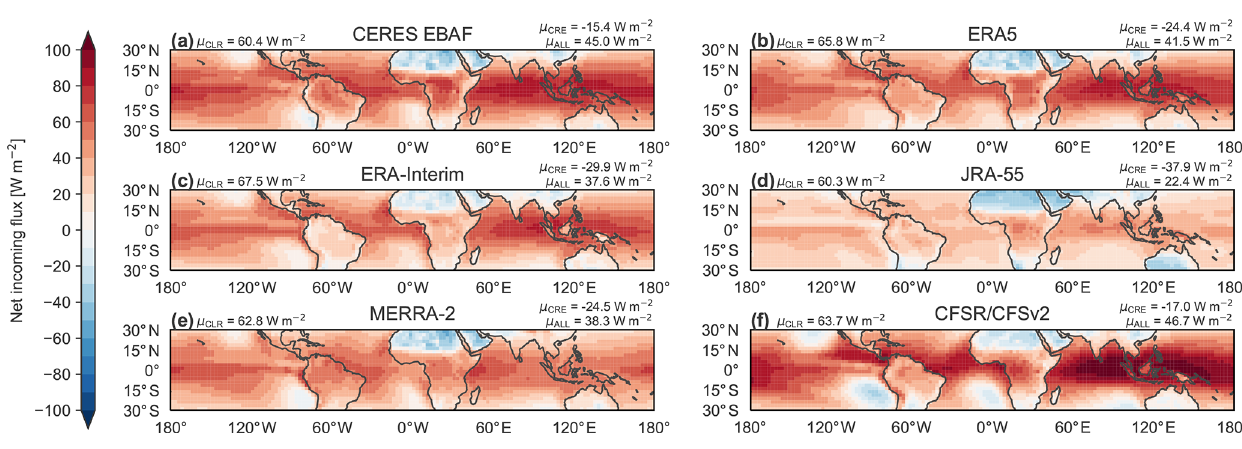
Figure 6. Climatological mean spatial distributions of all-sky net incoming radiation (ALL; shading) for (a) CERES EBAF, (b) ERA5, (c) ERA-Interim, (d) JRA-55, (e) MERRA-2, and (f) CFSR/CFSv2 during 2001–2014. Tropical-mean (30 ◦ S–30 ◦ N) values of ALL and clear-sky net incoming radiation (CLR) based on each product are shown at the upper-right and upper-left corners, respectively, of the corresponding panel. Tropical-mean values for the net cloud radiative effect (CRE = CLR − ALL) are listed above those for